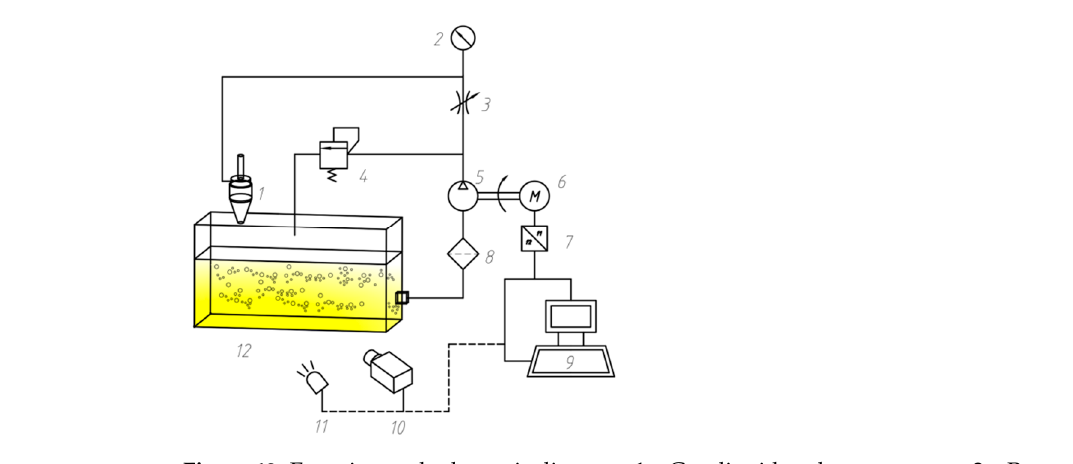
Figure 12. Experimental schematic diagram. 1—Gas–liquid cyclone separator; 2—Pressure gauge; 3—Throttle valve; 4—Safety valve; 5—Three screw pump; 6—Three-phase asynchronous motor; 7—Frequency converter; 8—Filter; 9—Computer; 10—High-speed camera; 11—Sheet light